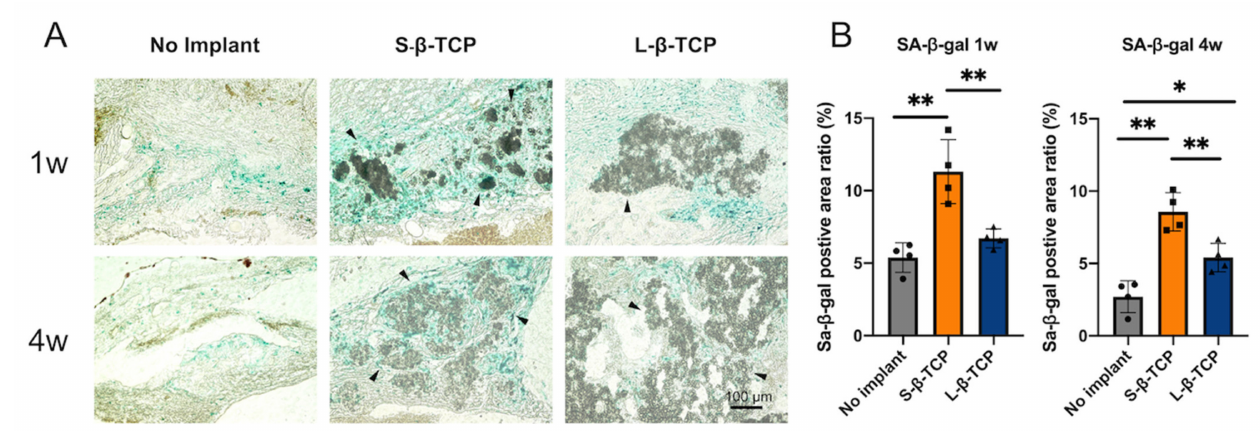
Figure 2. Identification of cellular senescence in bone defects at one week and four weeks after the operation. ( A ) Senescence- associated beta-galactosidase (SA- β -gal) staining images of bone defects (scale bar = 100 µ m). Black triangles represent β -TCP granules; ( B ) SA- β -gal positive area ratio in the bone defect. Mean with standard deviation (SD) ( n = 4). * p < 0.05, ** p < 0.01: One-way analysis of variance (ANOVA) with Tukey–Kramer method as post hoc test.